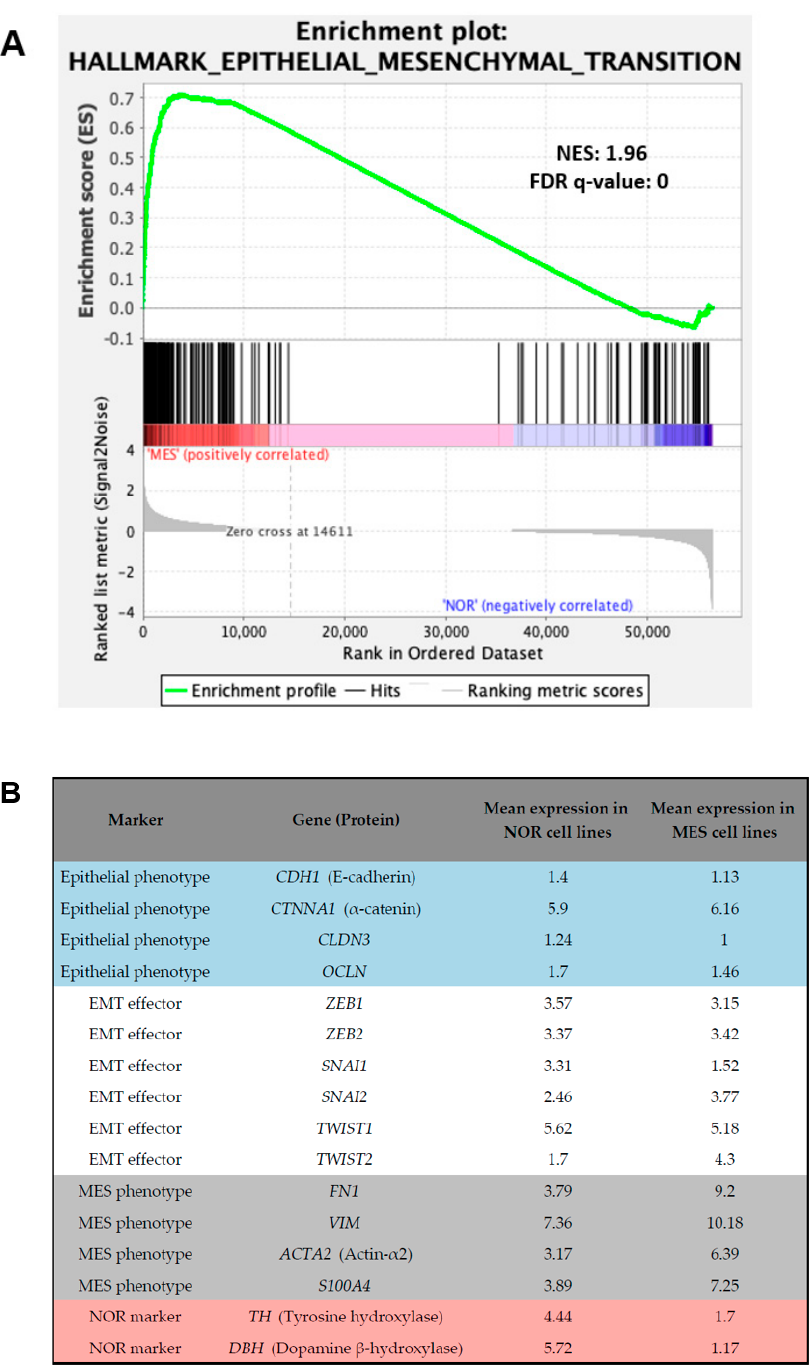
Figure 4. Neuroblastoma MES cells express typical mesenchymal markers but not EMT effectors. ( A ) GSEA analysis on noradrenergic and mesenchymal neuroblastoma cell lines revealed the hallmark category “epithelial-to-mesenchymal transition”. ( B ) Mean of the normalized expression values (Log2-transformed (FPKM+2)) obtained from RNA-seq data in the same cell lines for epithelial markers, EMT effectors, and MES and NOR markers. Data are from “Heterogeneity of neuroblastoma cell identity defined by transcriptional circuitries” by Boeva, V. et al., 2017, Nature Genetics, 49, 1408–1413, Adapted with permission from Ref. [19]. Copyright 2021 Springer Nature.